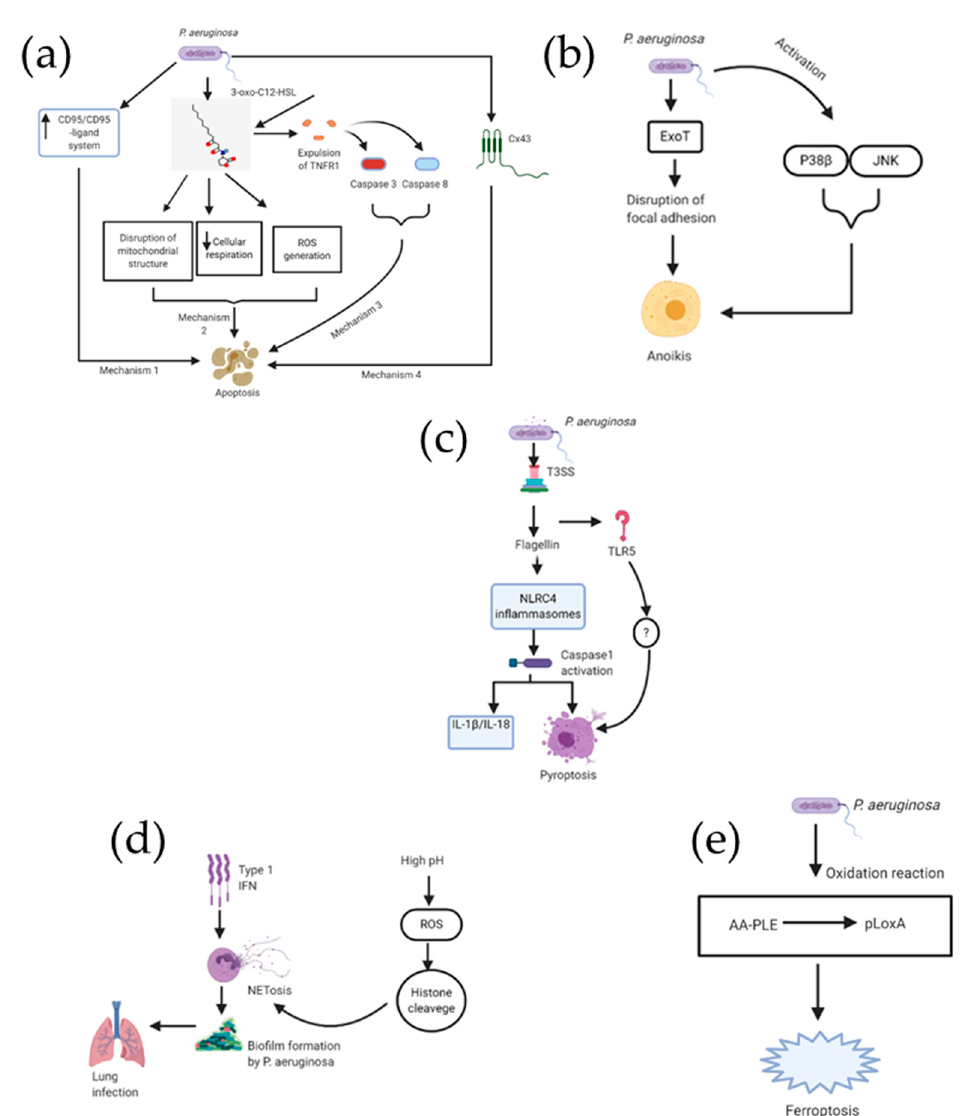
Figure 3. Schematic representation for the different cell death mechanisms caused due to P. aeruginosa